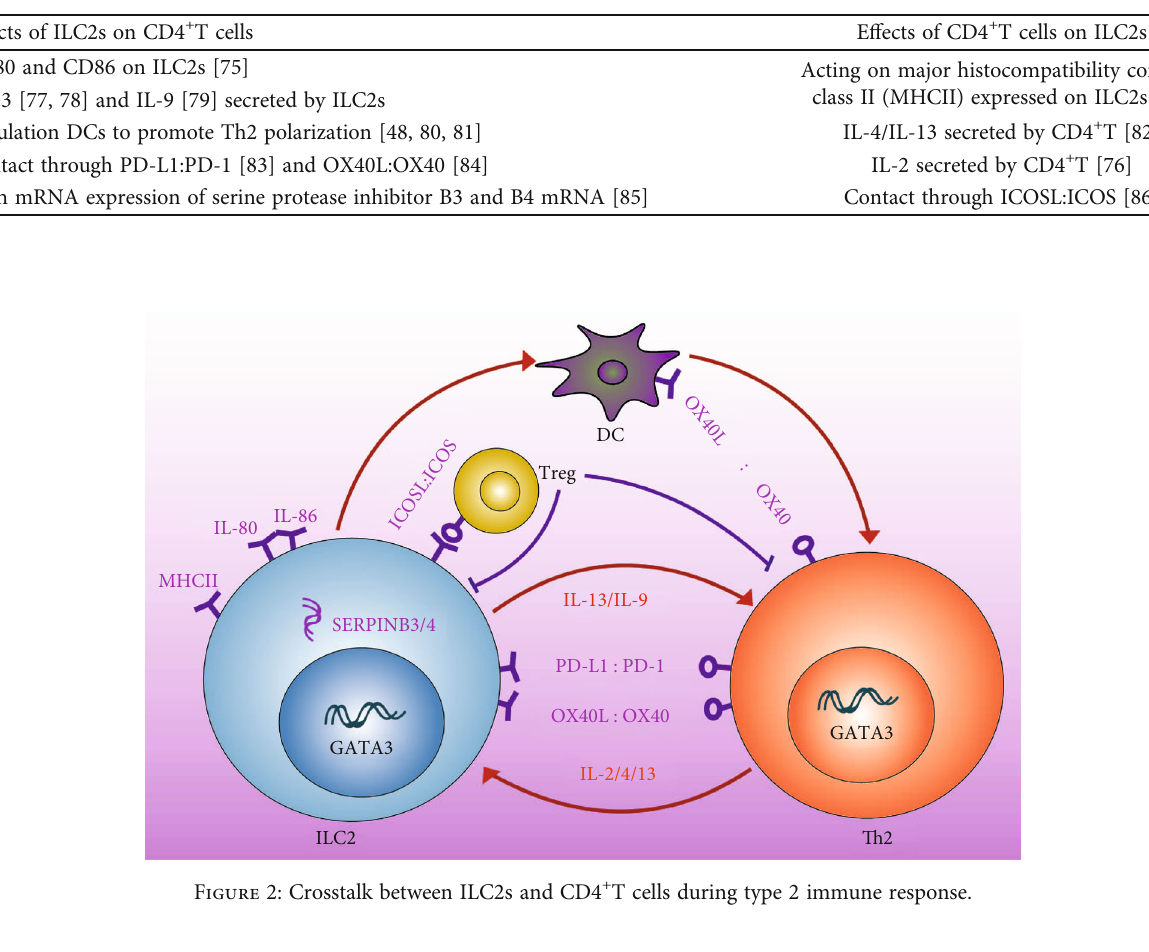
Table 1: Crosstalk mechanism between ILC2s and CD4+T cells.